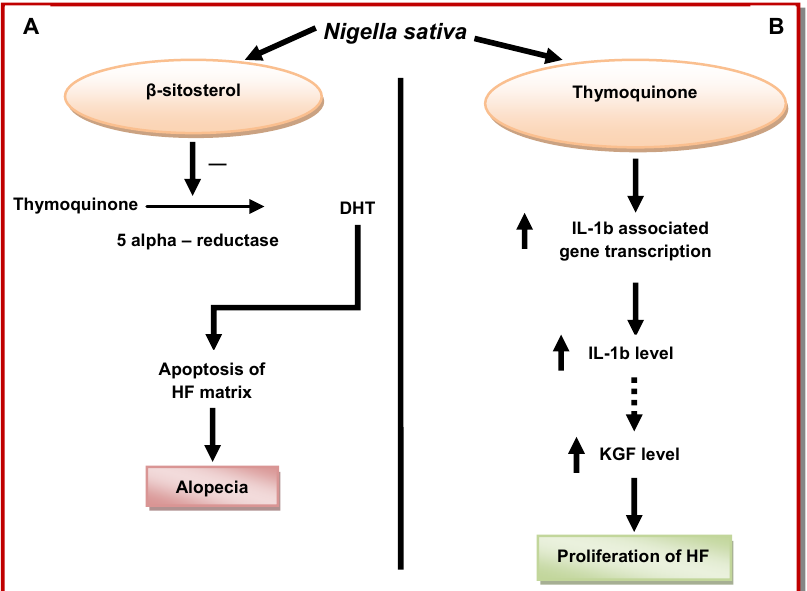
Figure 8: (A) β sitosterol inhibits 5 alpha-reductase. Hence, there is decreased production of DHT resulting in prevention from apoptosis. (B) Thymoquinone increases the level of IL-1 which enhances proliferation of HF by increasing secretion of KGF DHT: dihydrotestosterone, HF: hair follicles, IL-1: interleukin-1, KGF: keratinocyte growth